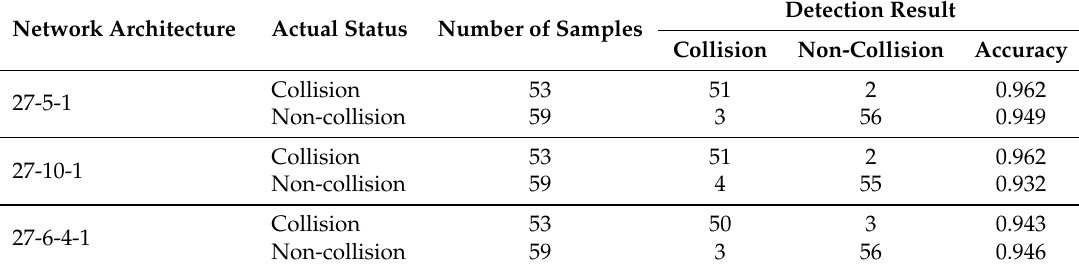
Table 5. Accuracy of collision detection.